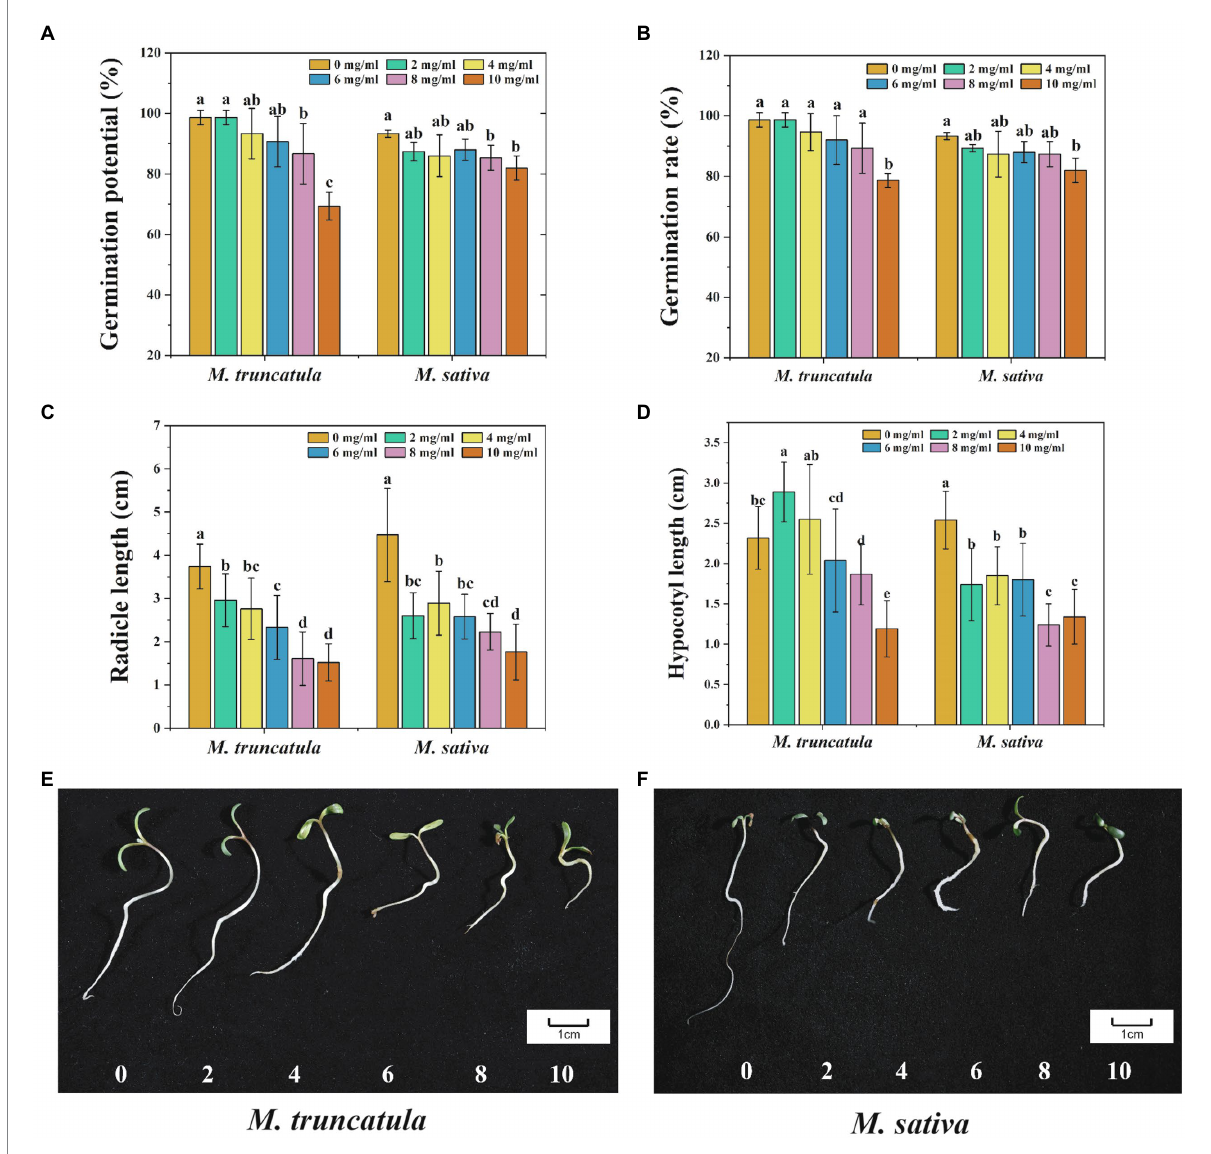
FIGURE 2 Effects of M. truncatula extracts on seed germination and seedling growth of M. truncatula and alfalfa. (A) Germination potential; (B) germination rate; (C) radicle length; and (D) hypocotyl length; (E) : M. truncatula seedling growth; (F) : alfalfa seedling growth. Values represent means±SD of three biological replicates. Different letters above the bars indicate a significant difference ( p <